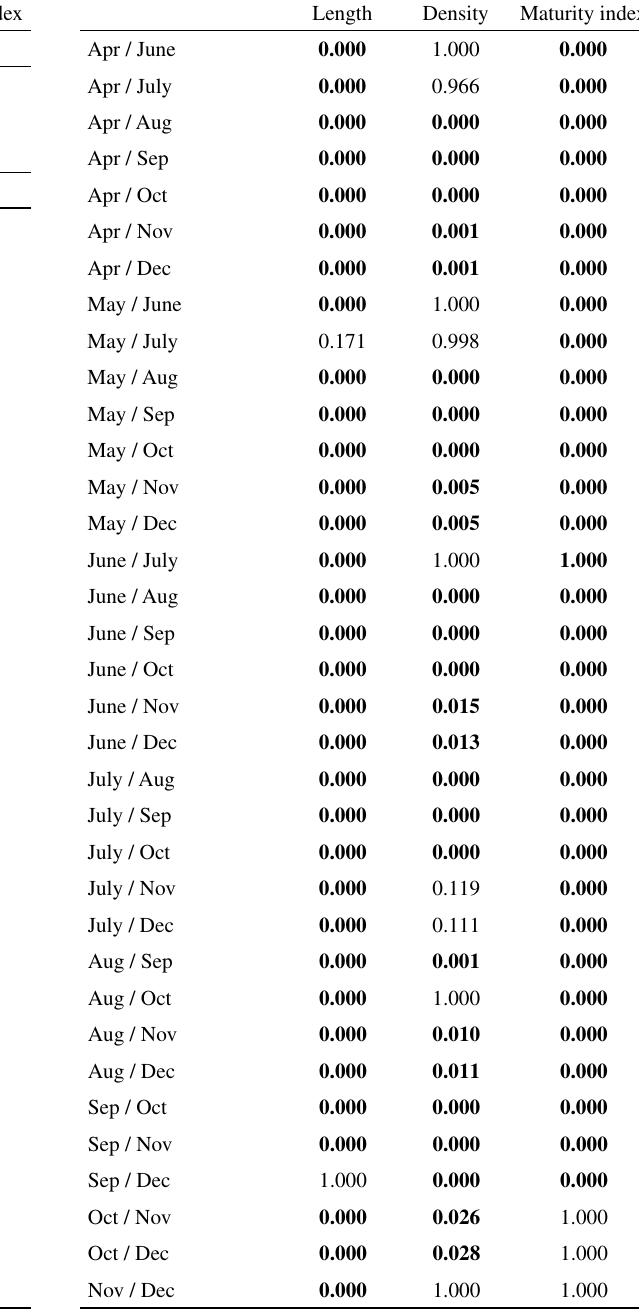
Table 2. – Tukey post hoc comparison testing the effects of site and sampling month on the thalli length, density and maturity index of Sargassum muticum communities on the Moroccan Atlantic coasts. Significant p ‐ values are shown in